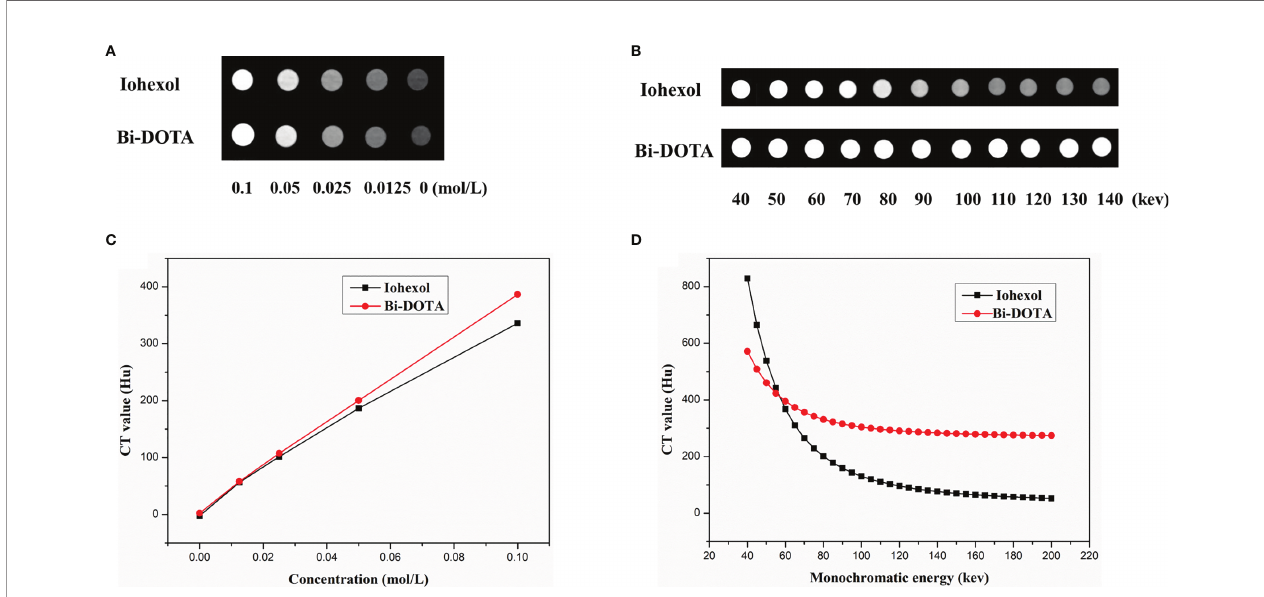
FIGURE 3 | (A) CT phantom imaging under different concentrations at 120 kV. (B) A linear relationship between CT values and the concentrations of both Bi-DOTA and iohexol. (C) Spectral CT monochromatic images under different energies using Bi-DOTA and iohexol. (D) Spectral CT value curves of Bi-DOTA and iohexol at different